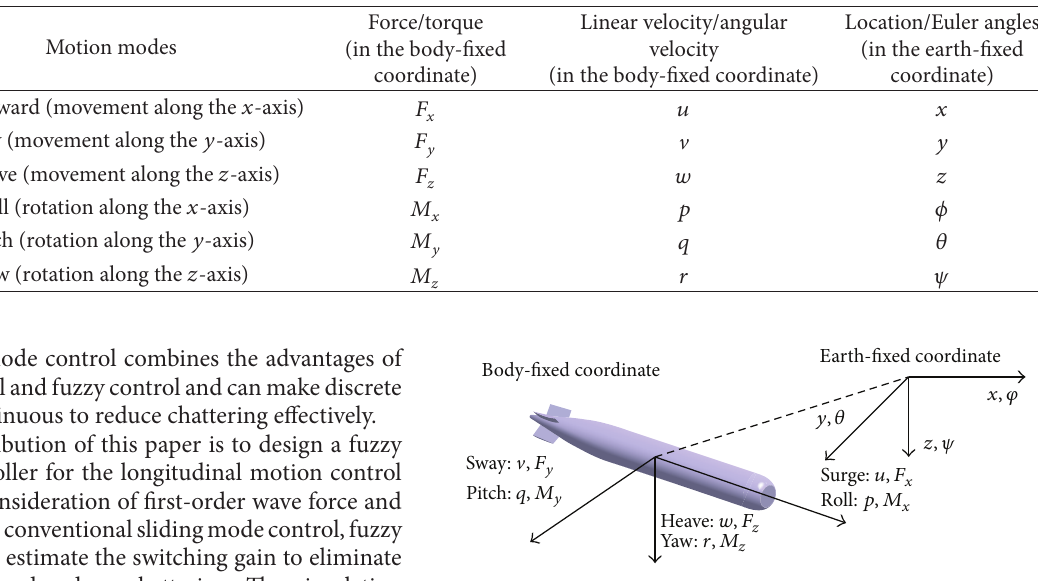
Figure 1: Reference coordinates and 6-DOF coordinates of